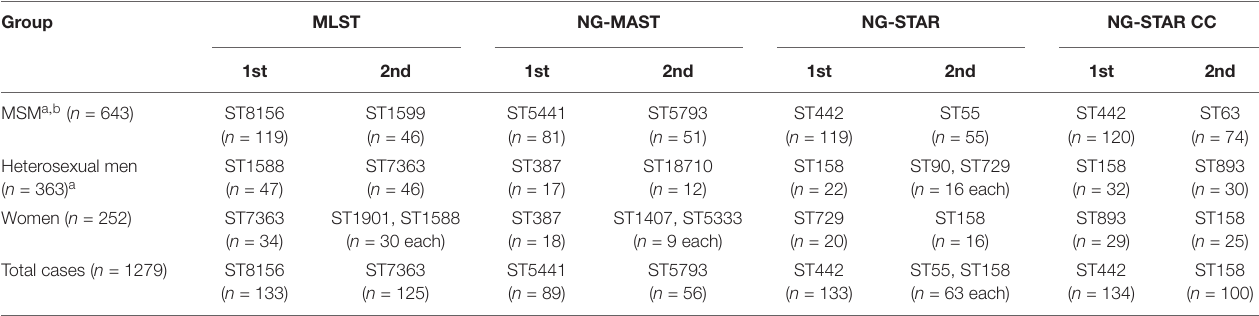
FIGURE 2 | Summary of patient characteristics (A–C) and Neisseria gonorrhoeae sequence types (D–F) of sublineages A1 and A2 and lineage B. Figures (D–F) Include sequence types of ≥ 10 isolates. MSM, men who have sex with men; MLST, multi-locus sequence typing; ST, sequence type; NG-STAR CC, Neisseria gonorrhoeae sequence typing for antimicrobial resistance clonal complex. TABLE 3 | Most common sequence types in Neisseria gonorrhoeae isolates in Sweden,